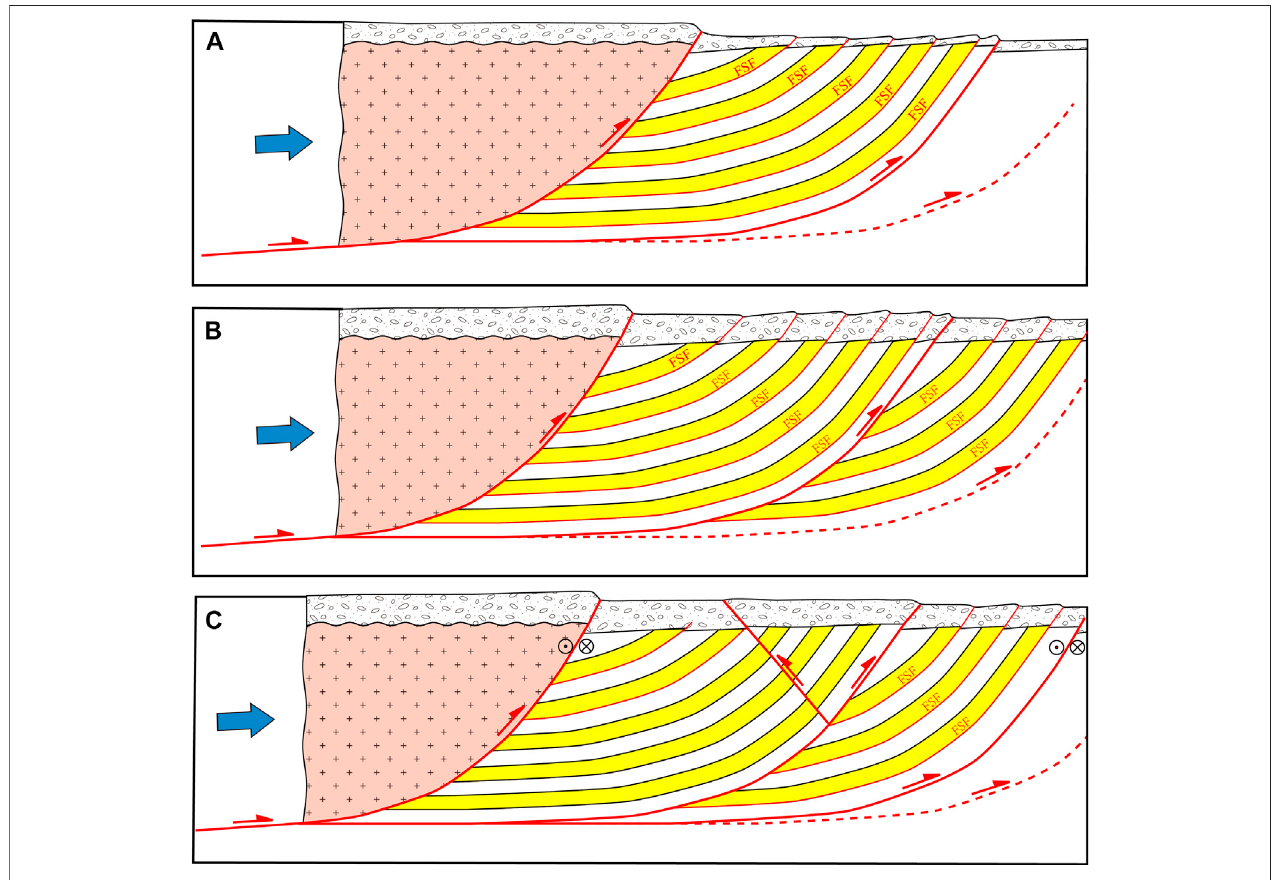
FIGURE 10 | The sketch map of Geometric and dynamic deformation of the SMQBF at three study sites (FSF represents fl exural slip fault).